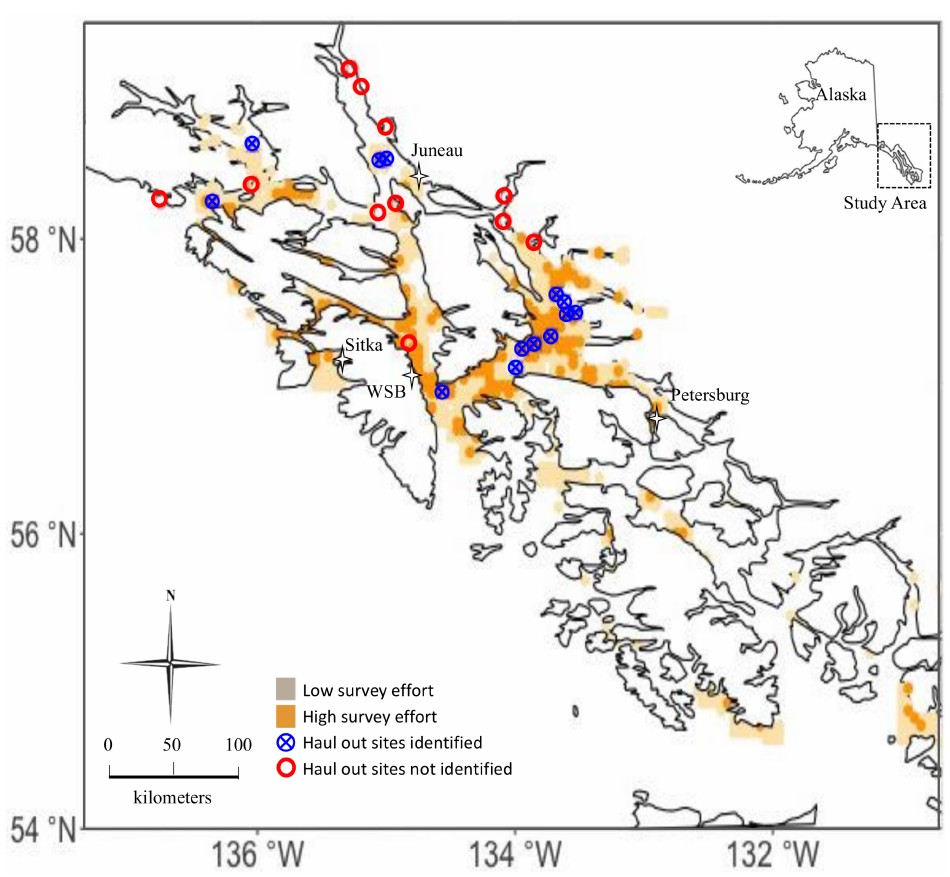
Figure 7. Map showing scientifically collected haul out sites [41] identified with Whale mAPP data in low and high survey effort areas.